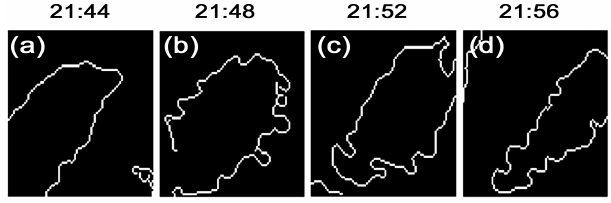
Figure 5. Sequential images of the detected target cloud on 17 April 2012 (Time as per IST in hh:mm